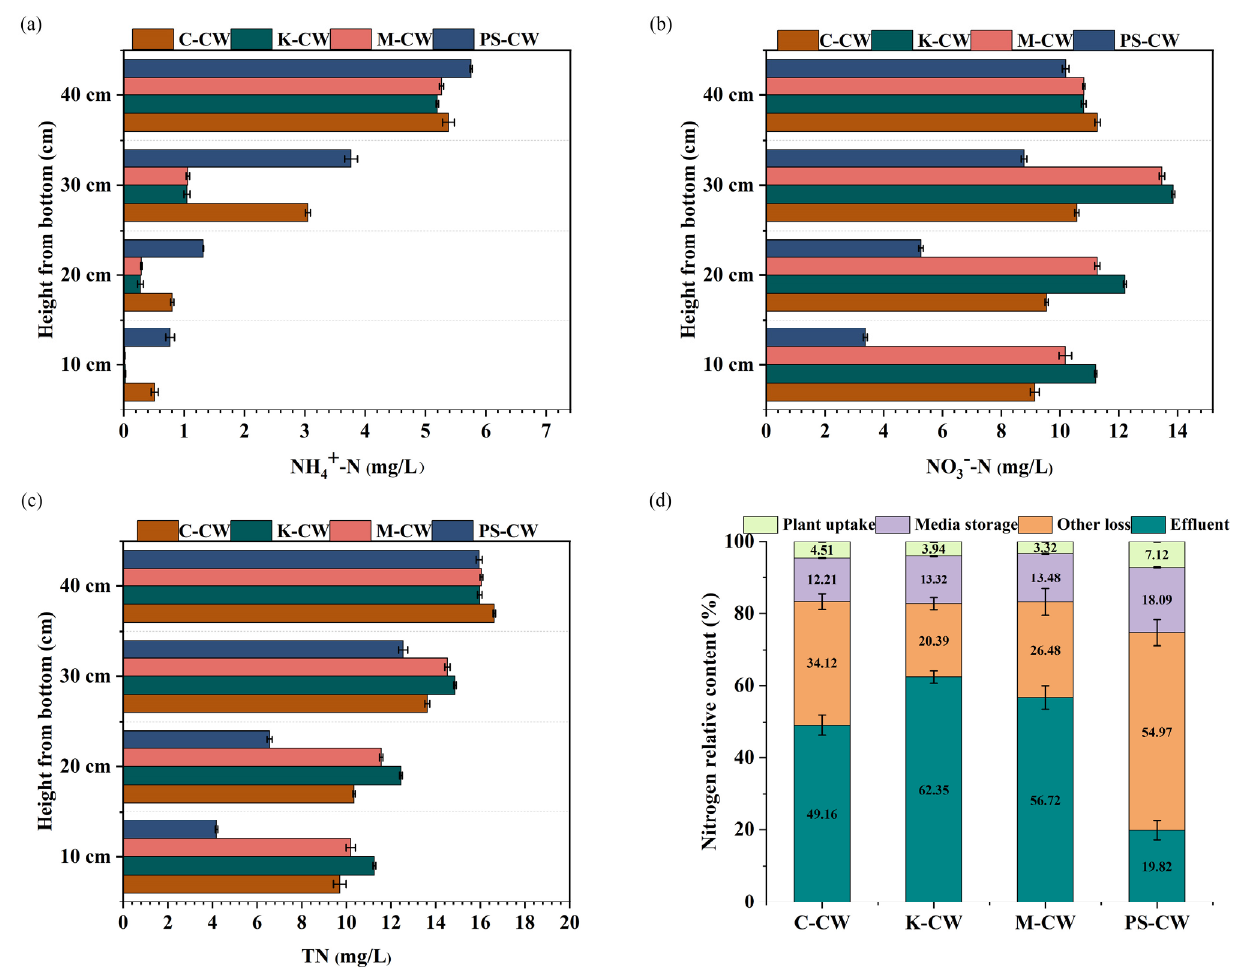
Figure 2. Concentration of NH 4+ − N ( a ), NO 3 − − N ( b ) and TN ( c ) in different layers from the bottom of CWs, and N mass balance ( d ) in C − CW, K − CW, M − CW and PS − CW. (Other loss was attributed to microbial